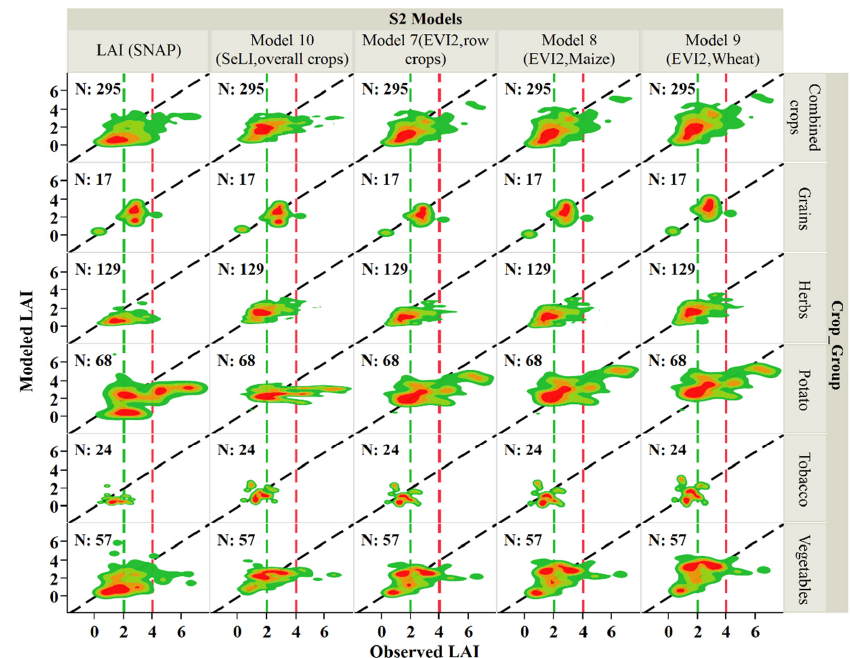
Figure 8 . Comparison between modeled and observed LAI in the 2018–2019 growing seasons for the HLS ‐ VI for the HLS VI best ‐ performing models derived from S30, Model 10 (SeLI, overall crops) and SNAP model derived from S2 THEIA product. The dashed green vertical lines represent the low observed LAI interval (0–2 m 2 /m 2 ), the dashed red vertical lines represent the high observed LAI interval ( > 4 m 2 / m 2 ), and the region between these two vertical lines represents the medium observed LAI range (2–4 m 2 / m 2 ), the 2 ‐ D density plots represent four color levels with a dark red color at high density to dark green at lower densities, in addition to the orange and light green in representing medium densities.